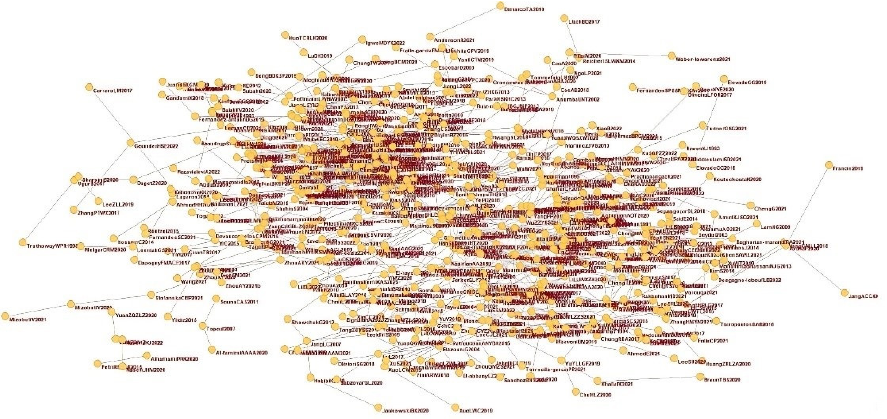
Figure 4. Citation network for the 587 articles in the Final Dataset A.